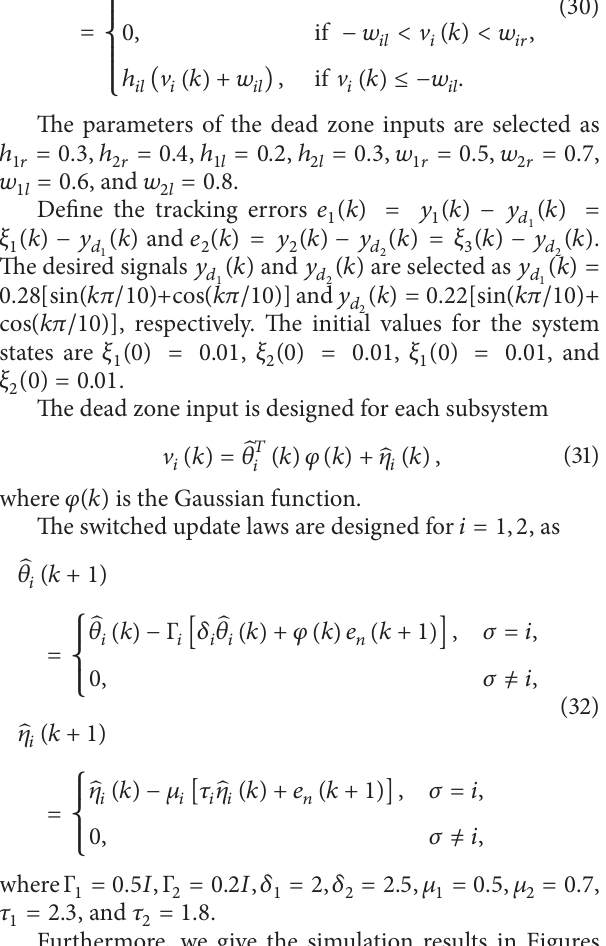
Figure 2: The trajectories of 𝑦 2 and 𝑦 𝑑